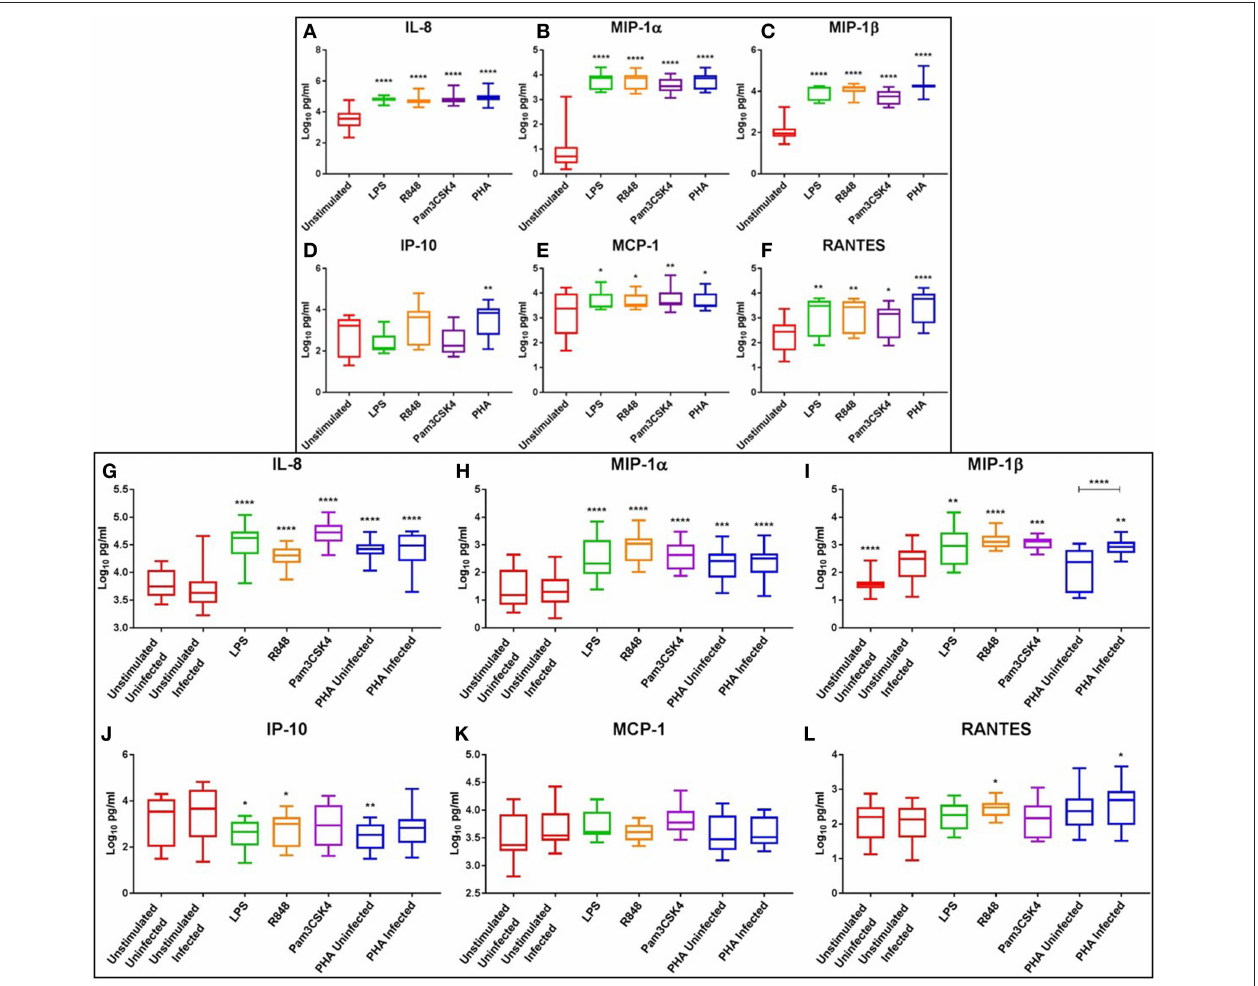
FIGURE 5 | Box and Whisker plots showing mean ± SD Log10 concentrations of chemotactic cytokines IL-8 (A,G) , MIP-1 α (B,H) , MIP-1 β (C,I) , IP-10 (D,J) , MCP-1 (E,K) , and RANTES (F,L) from unstimulated (red), LPS (green), R848 (orange), Pam3CSK4 (purple), and PHA (blue) conditions on day 3 prior to HIV infection (top box: A–F ) and day 5 post HIV infection (bottom box: G–L ). TLR agonists were used at a final concentration of 2 µ g/ml. PHA was used at a final concentration of 10 µ g/ml. All TLR stimulation conditions were infected. An ordinary one-way ANOVA with a Dunnett’s multiple comparisons test was performed. Significance displayed as * p < 0.05, ** p < 0.01, *** p < 0.001, **** p ≤ 0.0001 compared to the unstimulated control. Sample size, n = 5, 4 donors run in quadruplicate, 1 donor run in